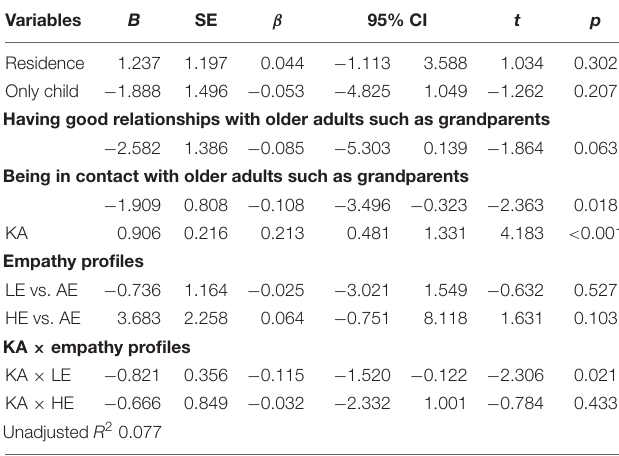
TABLE 7 | Regression analysis predicting KAOP– from KA and empathy